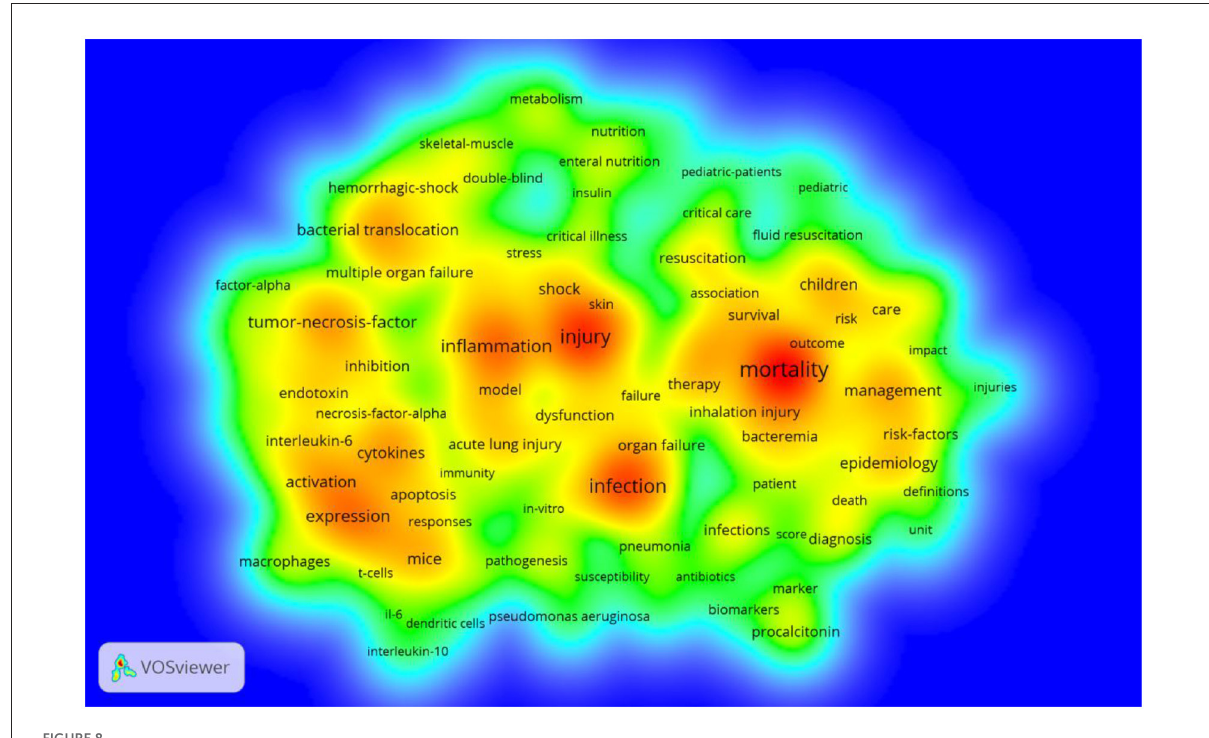
FIGURE8 Bibliographic analysis of all keywords in density visualization map. The color represents the density of the keyword. Red represents a more frequent appearance, and green represents a less frequent